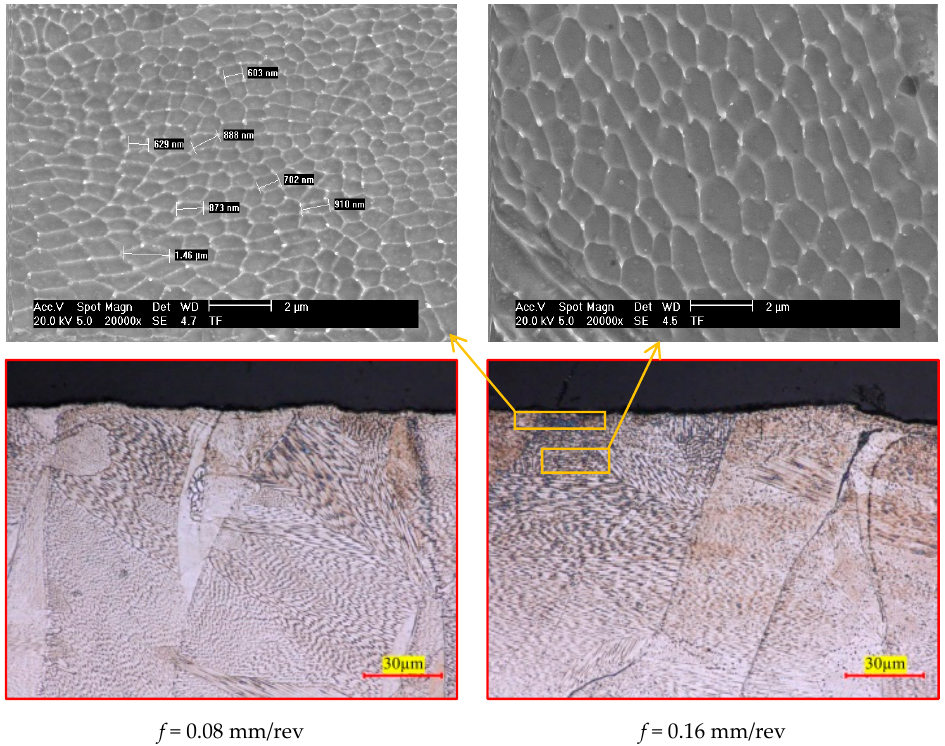
Figure 11. The effect of feed rate on microstructure of SLMed 316L part ( V c = 150 mm/min).